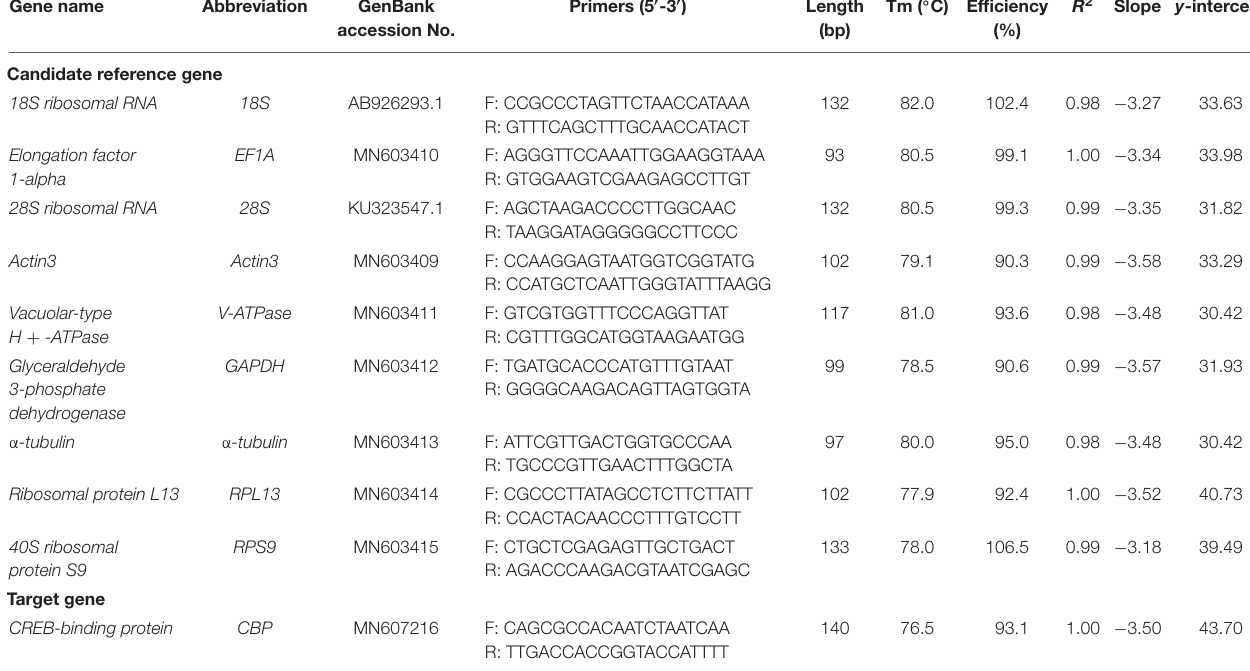
TABLE 1 | Primer sets used in this